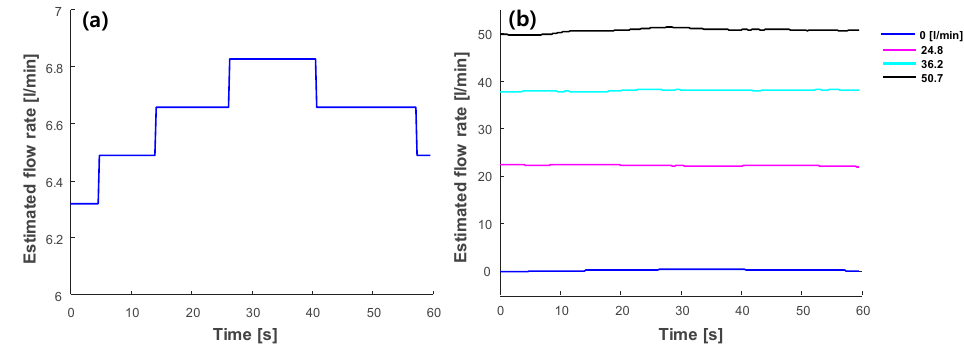
Figure 7. Estimated flows for ( a ) no flow, and ( b ) eight flow rates (reference flows at 0, 24.8, 36.2, and 50.7 L/min) after zero-flow calibration.